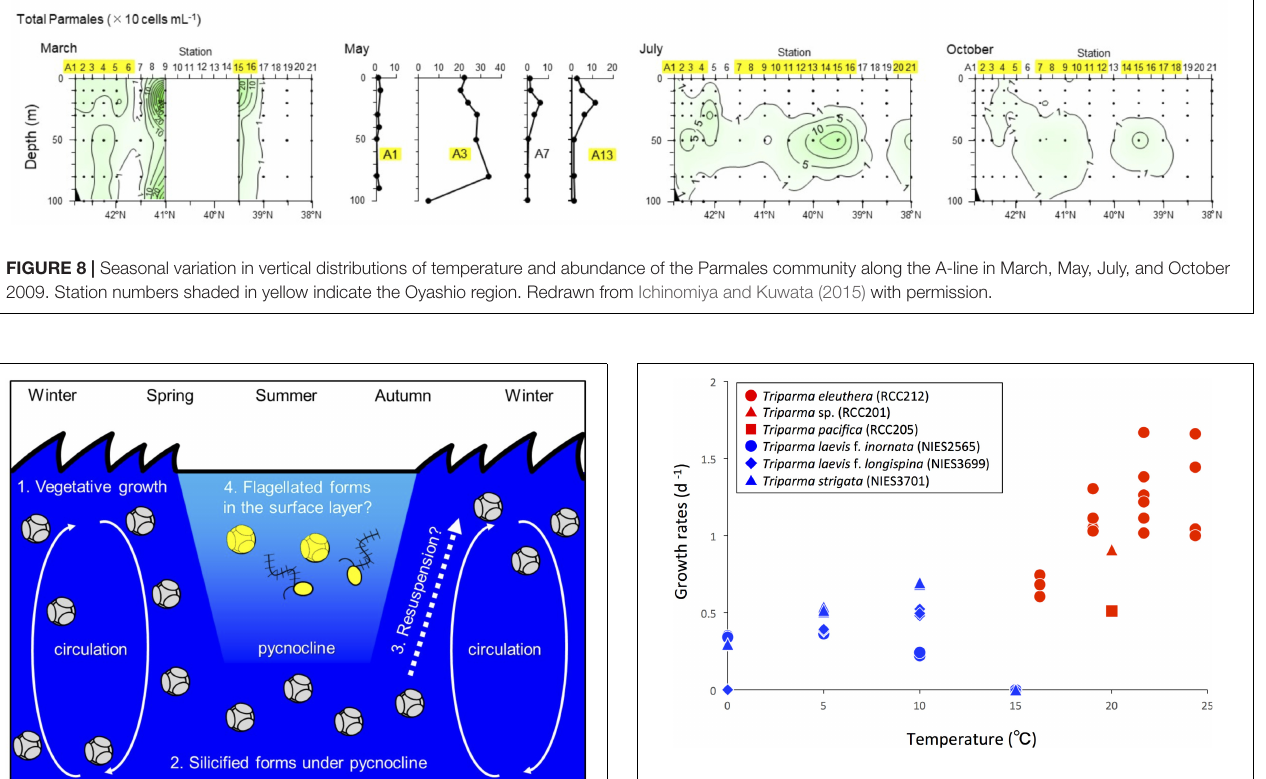
FIGURE 10 | Growth rates of the silicified (blue symbols) and naked flagellated (red symbols) Triparma strains. Data redrawn from Stawiarski et al. (2016) for T. eleuthera (RCC212), Jacquet et al. (2001) for Triparma sp. (RCC201), Thomas and Campbell (2013) for T. pacifica (RCC205) and Ichinomiya and Kuwata (2015) for T. laevis f. inornata (NIES-2565), T. laevis f. longispina (NIES-3699), and T. strigata